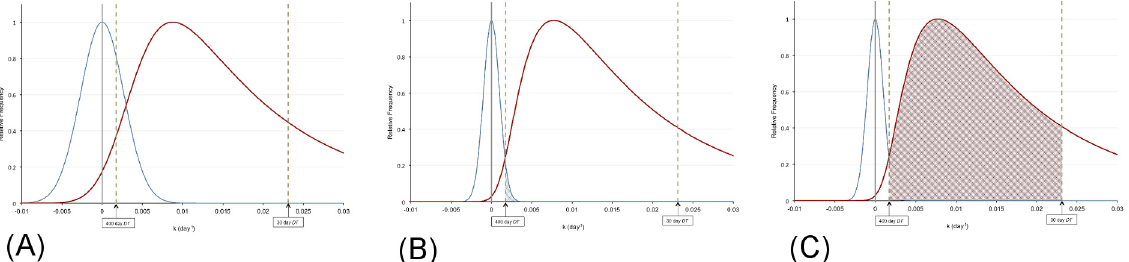
Fig 2. Normalized population distributions for stable and malignant nodules as a function of the scan interval, Δ T . The stable nodules are described by a normal distribution centered at k = 0 zero and the malignant nodules are described by a lognormal distribution. (A) 30-day scan interval. (B and C) 81-day scan interval. Note the decrease in width of the distributions with a longer scan interval due to the effect of the scan interval time, Δ T , on the standard deviation for k as given by Eq 4 in the Appendix. In Fig 2B, FPR is computed as the percent area under the stable curve between the 400-day and 30-day doubling time values (0.00173 < k < 0.0231 day -1 ) (vertical dashed lines). In Fig 2C, TPR is computed as the percent area under the malignant curve between the same